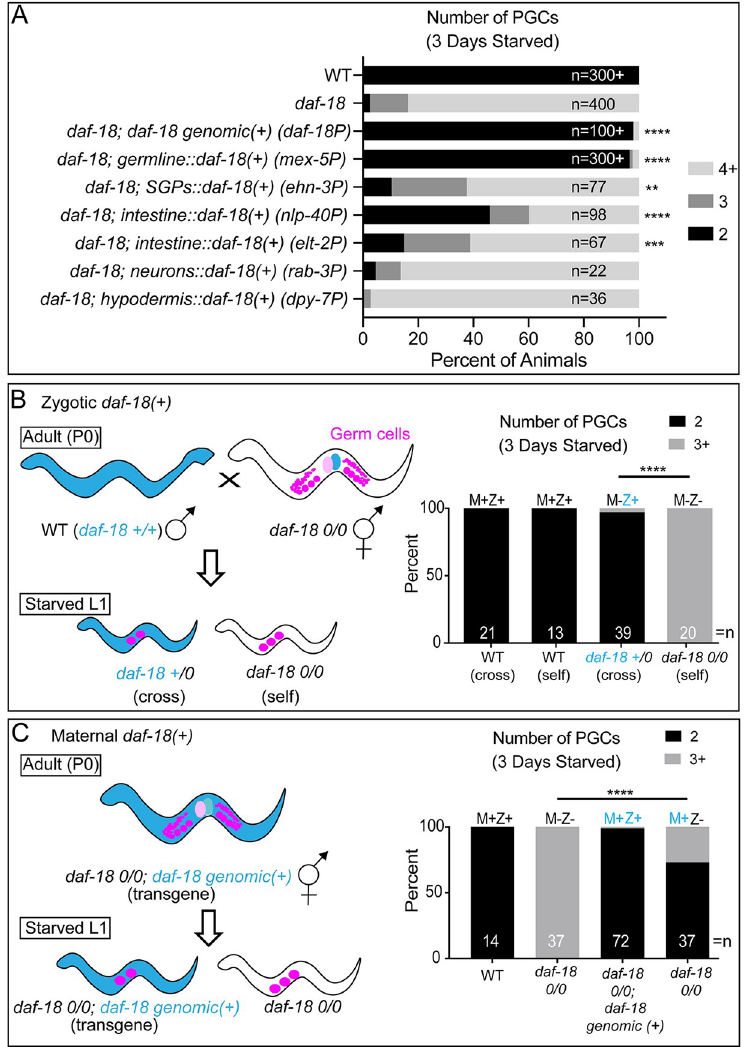
Fig 2. DAF-18 acts in the germ line and soma to suppress PGC division during starvation. (A) The number of PGCs in L1 larvae was assessed after 3 days of starvation. Genotypes indicate the promoters used to drive tissue- restricted expression of the daf-18 coding region containing all introns and daf-18 3’UTR, with the exception of germline :: daf-18(+) , which contains the same daf-18 coding region with introns, but the nos-2 3’UTR. All animals carry PGC :: mCherry , except for daf-18; germline :: daf-18(+) , which carries the PGC marker glh-1 :: GFP or no additional PGC marker ( germline :: daf-18 is tagged with GFP; see S2 Fig). n values display the total number of animals examined for each genotype. Chi-square statistical tests (or two-sided Fisher’s exact test for ehn-3P , elt-2P , rab-3P and dpy-7P ) were performed on each genotype compared to its own experimental control group ( daf-18(ok480) mutant with PGC :: mCherry ) and significance is displayed: �� p < 0.01, ��� p < 0.001, ���� p < 0.0001. Additional independently-generated transgenic lines were examined for several transgenes, with similar results found: 3 additional lines of daf-18P :: daf- 18(+) (suppressed daf-18 ), 2 additional lines of nlp-40P :: daf-18(+) (suppressed daf-18 ), 1 additional line of dpy-7P :: daf-18(+) (no suppression), and 1 additional line of rab-3P :: daf-18(+) (no suppression). (B) Zygotic DAF-18 maintains PGC quiescence. Blue color indicates the presence of daf-18(+) . Strategy is shown to generate Maternal-Zygotic+ (M- Z+) by crossing paternal daf-18(+) to daf-18 mutant hermaphrodites. This strategy gives starved L1 cross-progeny one wild-type copy of daf-18 in the absence of maternal daf-18 . Cross- versus self-progeny were identified by the presence/ absence of a bright somatic fluorescent marker from the paternal P0 strain (carrying cdc-42 :: GFP ). Number of PGCs were assessed after 3 days of starvation of L1 progeny. Statistical significance determined by two-sided Fisher’s exact test. ���� p < 0.0001. (C) Maternal DAF-18 also maintains PGC quiescence. Blue color indicates the presence of daf-18 (+) . Strategy is shown to provide maternal daf-18(+) in the presence (M+Z+) or absence (M+Z-) of zygotic daf-18(+) by analyzing the progeny of daf-18 mutants (0/0) carrying a daf-18(+) genomic transgene. This transgene was stochastically lost in progeny, yielding M+Z+ or M+Z- L1 larvae, which were assessed for PGC numbers after 3 days of starvation. Statistical significance determined by two-sided Fisher’s exact test. ���� p < 0.0001.